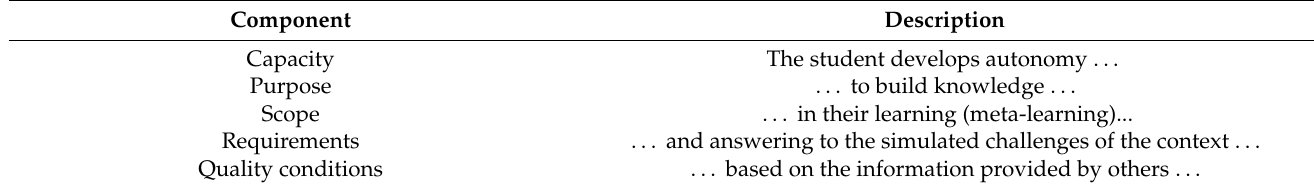
Table 2. Example of the formulation of competencies. Competency: meta-learning.